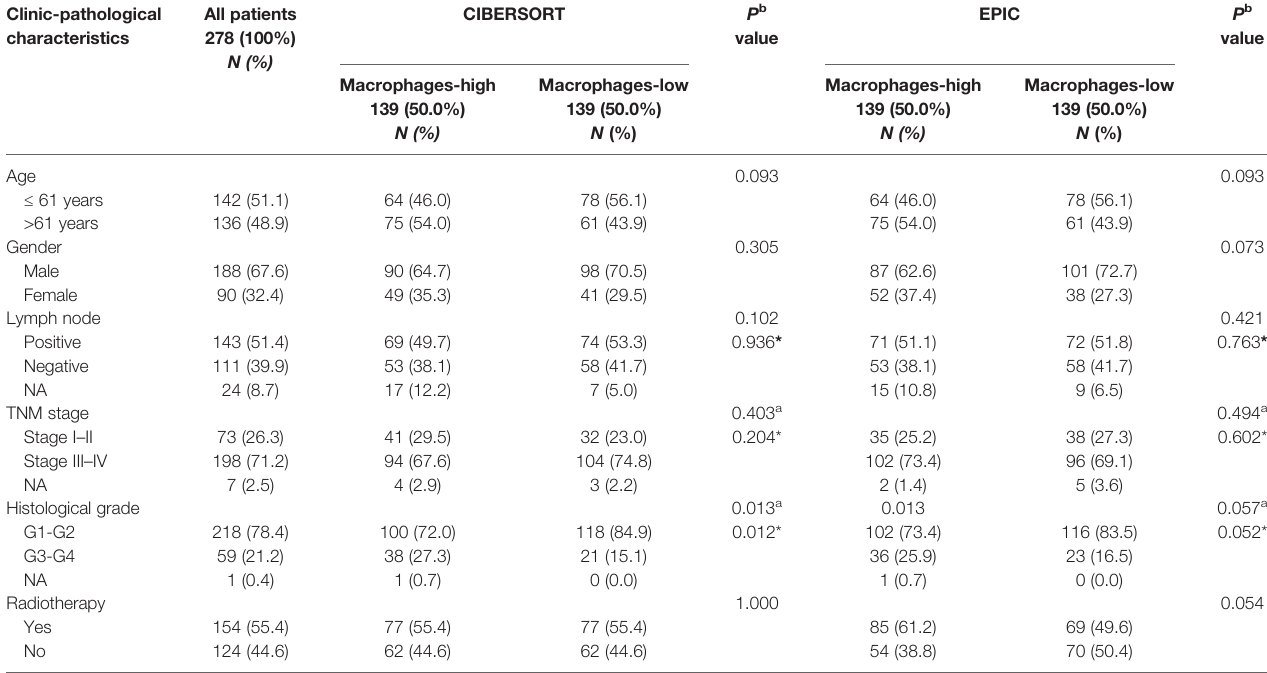
TABLE 2 | Correlation of macrophage in fi ltration deconvolved using CIBERSOFT and EPIC with clinic-pathological characteristics of OSCC patients in TCGA cohort. Clinic-pathological characteristics